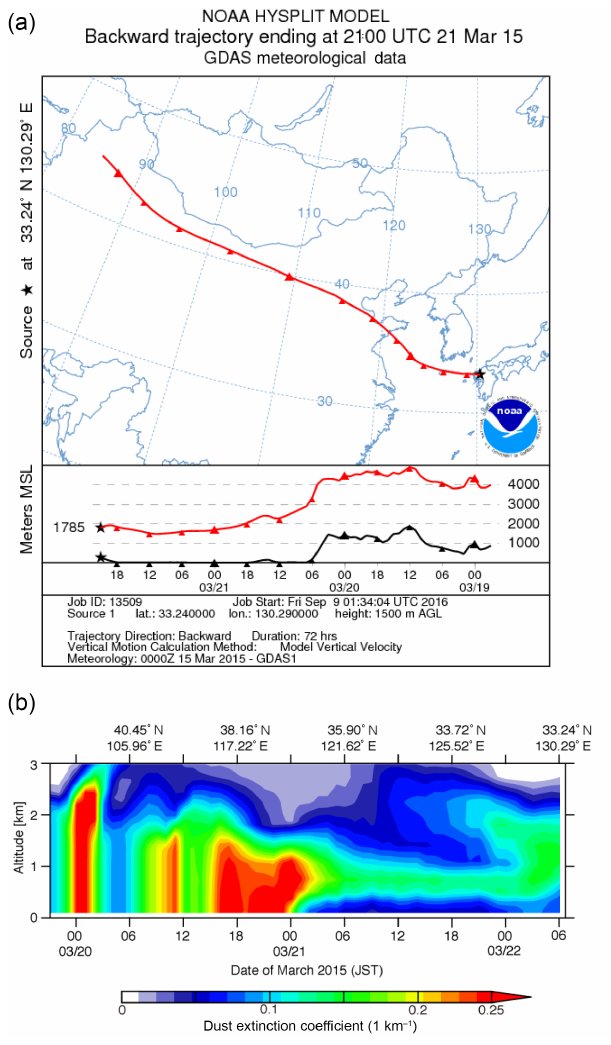
Figure 9. Same as Fig. 8, but for 500m